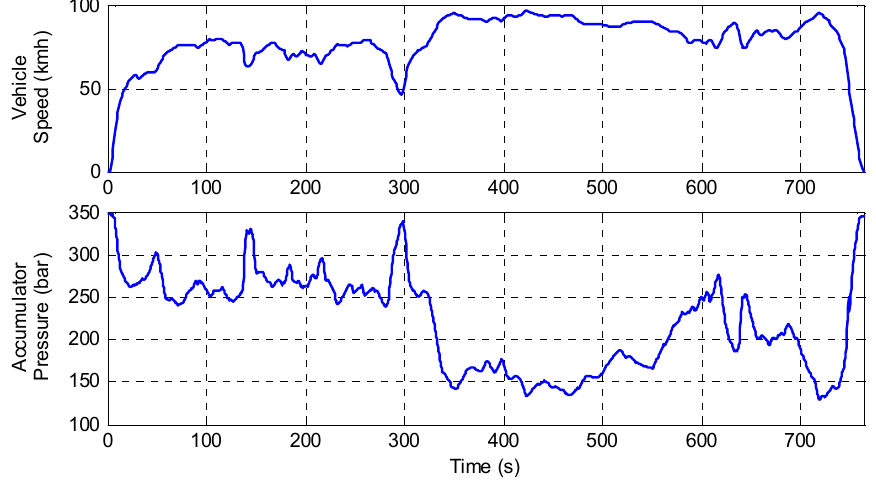
Figure 13. Accumulator Pressure Trajectory under Highway Fuel Economy Test (HWFET).